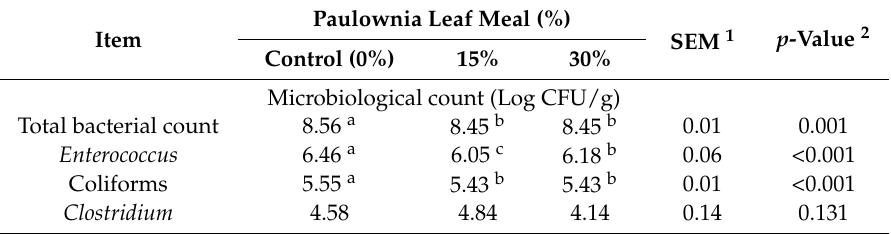
Table 8. Effects of paulownia leaf meal on cecal microbiota (total bacterial count and Enterococcus , coliform, and Clostridium counts) in growing New Zealand White